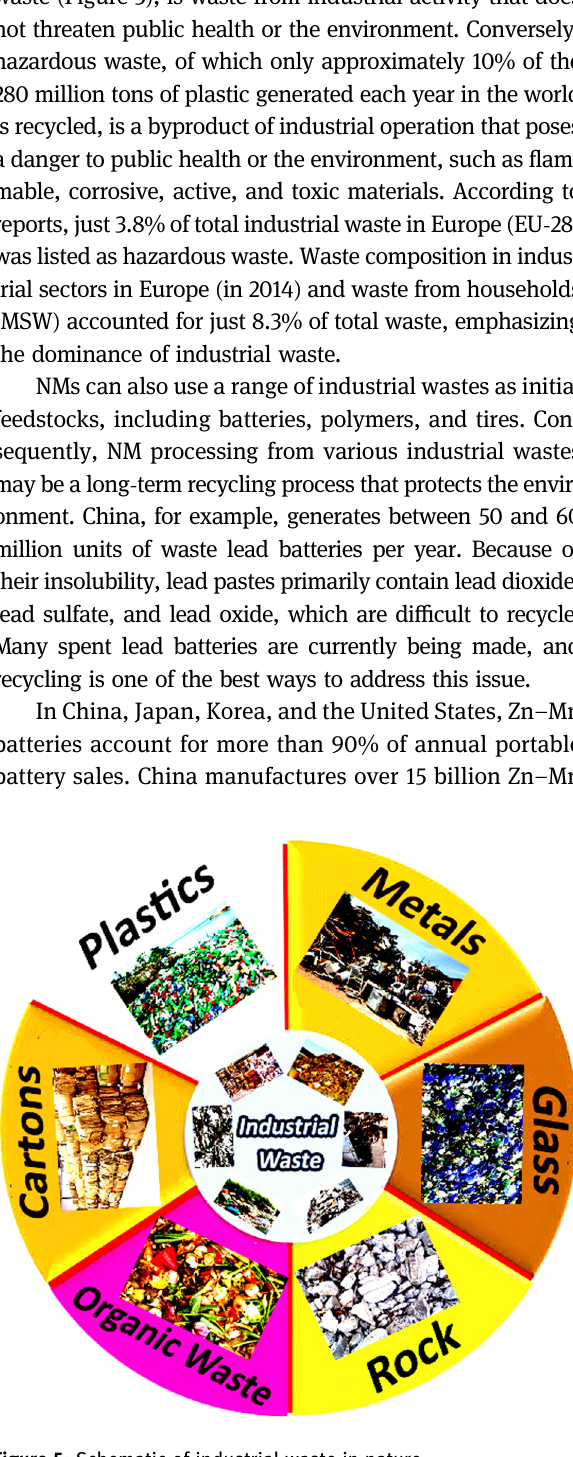
Figure 4: Schematic of biomass resources in nature. Figure 5: Schematic of industrial waste in